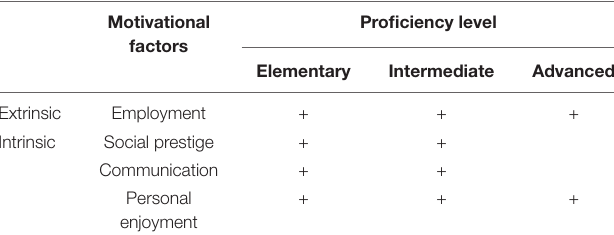
TABLE 8 | Common motivational factors among the three group of participants.